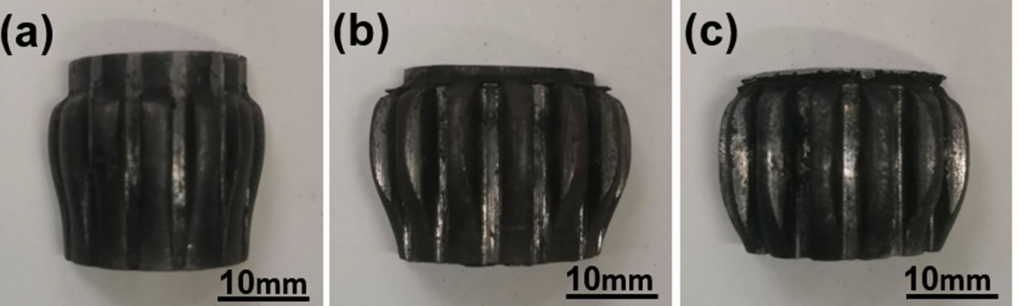
Figure 5. Bi-metal gear samples with different degrees of deformation: ( a ) 50%, ( b ) 70%, ( c ) 90%.